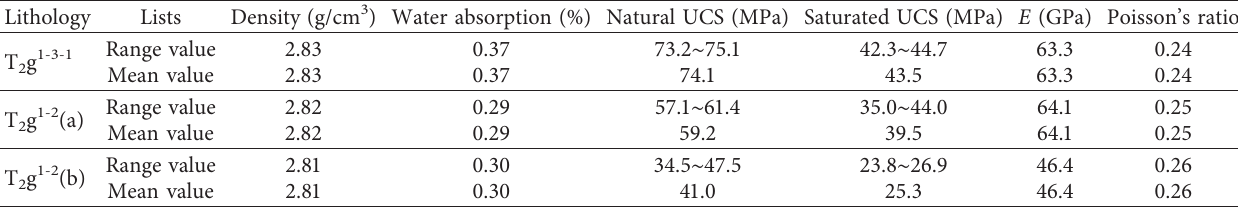
Table 2: The physical and mechanical parameters of these limestones from Ronglai hydropower station. Lithology